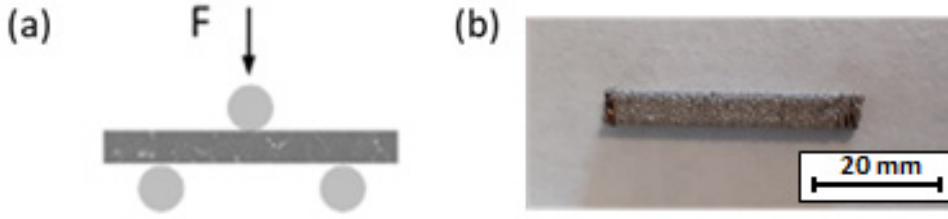
Figure 4. ( a ) Three-point bending test configuration; ( b ) bending sample used.